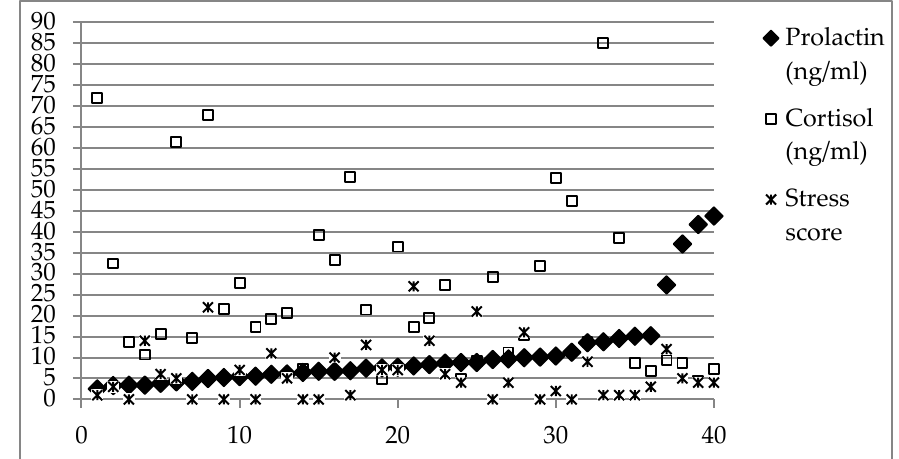
Figure 1 .Results of serum prolactin, serum cortisol and stress score. Values for prolactin in serum (ng/mL), cortisol in serum (ng/mL) and stress score for each dog (n = 40) are shown. Data are organized according to increasing value of prolactin.